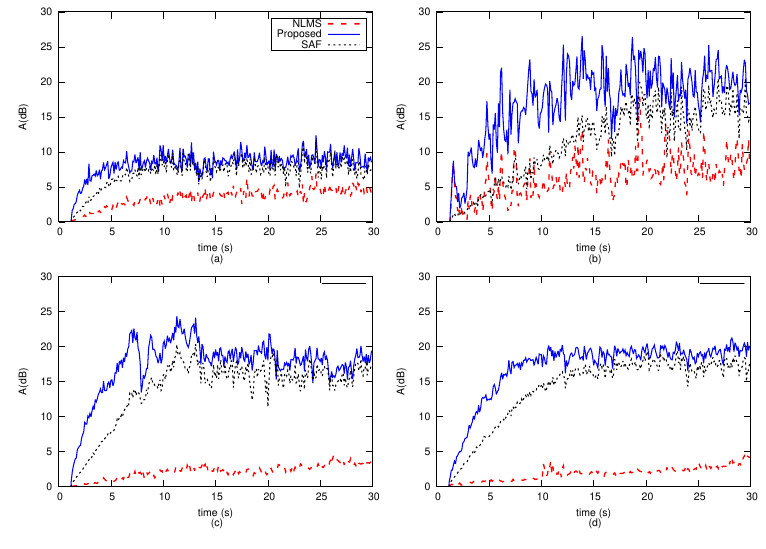
Figure 11. Test case 3: comparison of the noise reduction achieved in an ANC system. The reference signal is aircraft noise ( a ), kindergarten noise ( b ), outside traffic road ( c ) and jack-hammer ( d ). The legend is the same for all sub